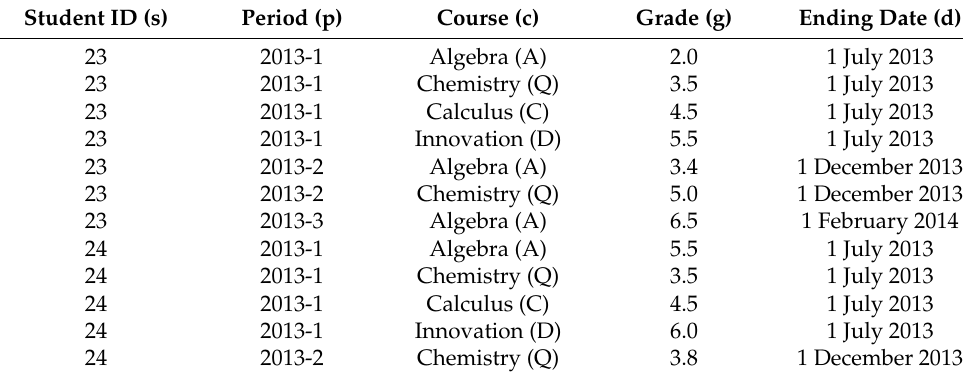
Table 2. Example of table